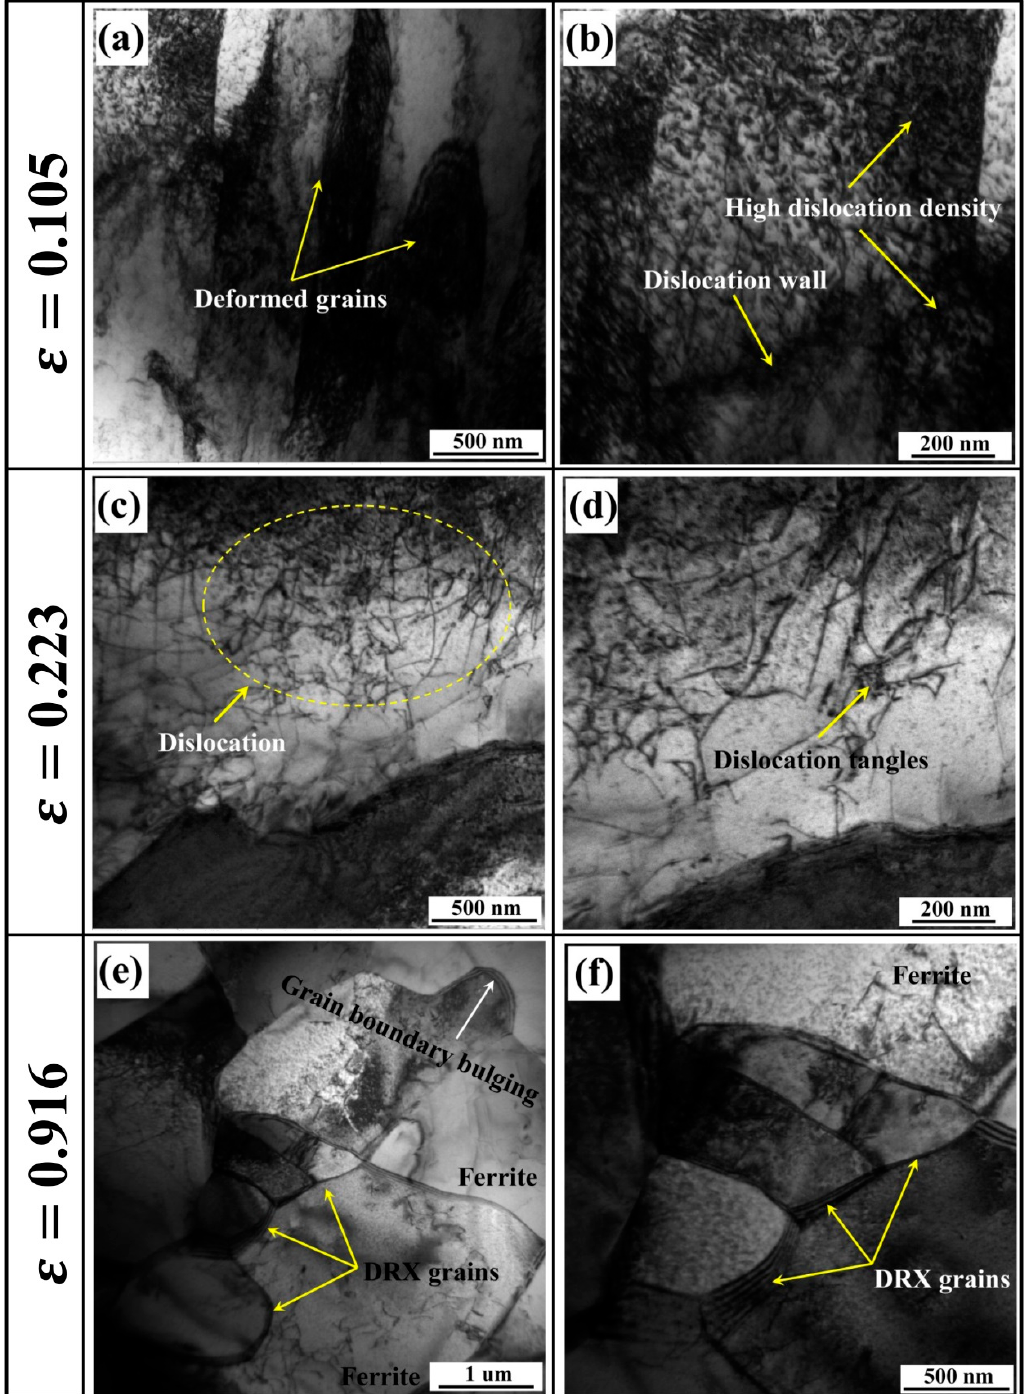
Figure 9. Dislocation and substructure of the specimens deformed at 950 °C and 0.01 s − 1 with different true strains: ( a , b ) ε = 0.105, ( c , d ) ε = 0.223, ( e , f ) ε = 0.916.